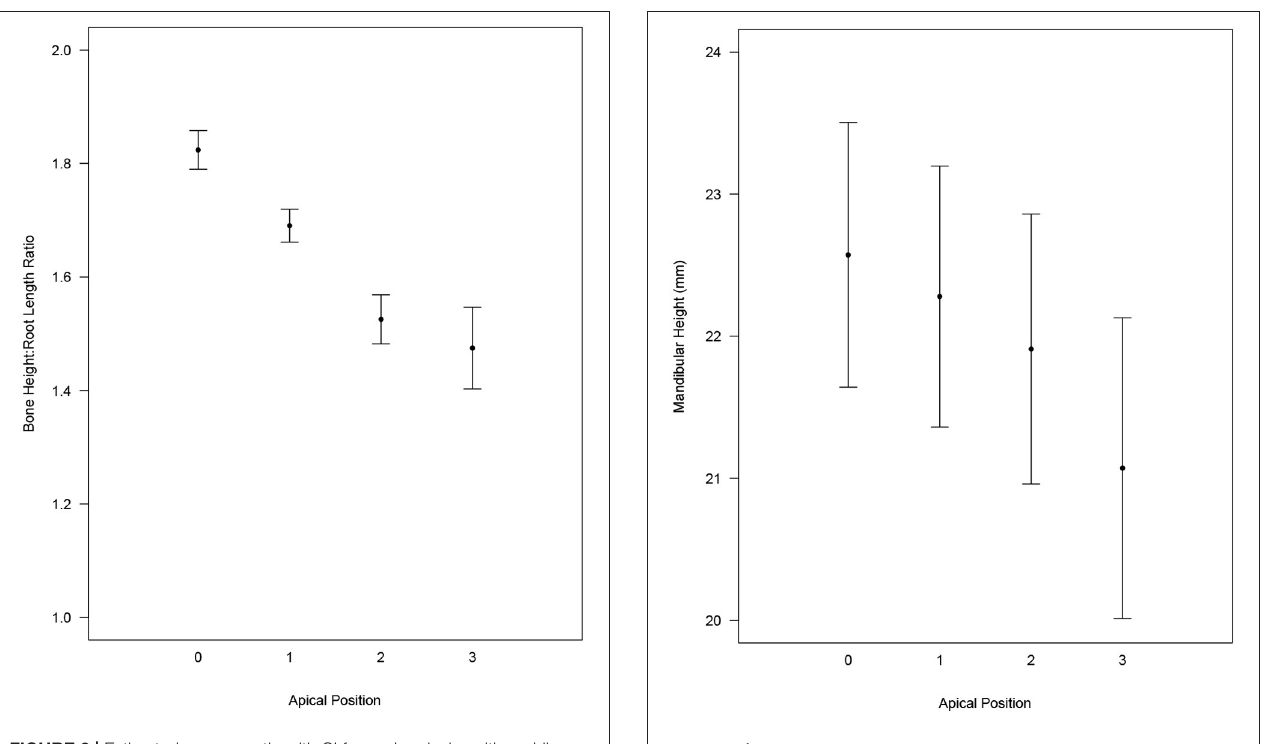
the mandibular canal of the distal root than the mesial root.